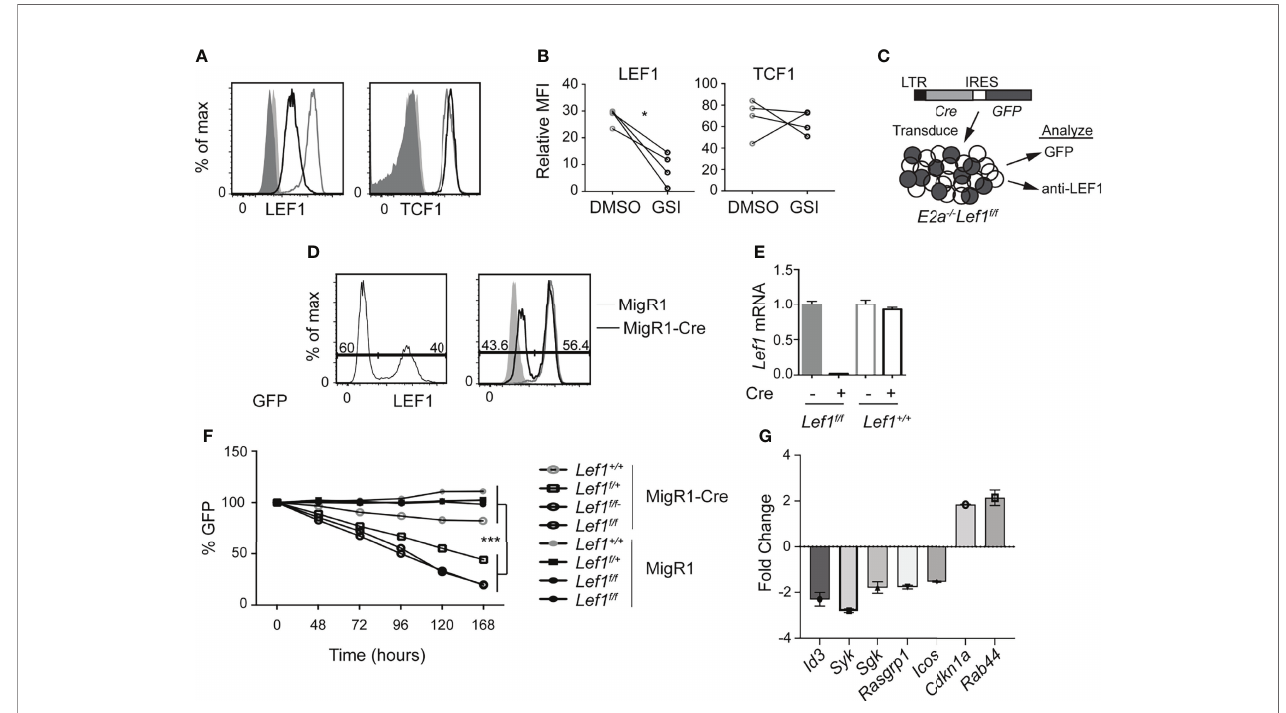
FIGURE 1 | LEF1 is required for the survival of established E2a -/- T cell leukemias. (A) Flow cytometry for LEF1 (left) or TCF1 (right) in an E2a -/- T cell leukemia line treated with DMSO (grey) or the Notch1 inhibitor GSI (black). Shaded histograms are isotype control stainings. n = 4 (B) Summary of the MFI for LEF1 or TCF1 in multiple E2a -/- leukemia lines. *p < 0.05, Students t-test. (C) Schematic representation of experiment to inactivate Lef1 in E2a -/- Lef1 f/f T cell leukemias. (D) Expression of GFP (left) or LEF1 (right) in E2a -/- Lef1 f/f leukemias transduced with MigR1-Cre (black). For LEF1 staining, MigR1 transduced cells (grey) and isotype controls (shaded histograms) are also shown. (E) qRT-PCR analysis for Lef1 mRNA in GFP + cells isolated from E2a -/- leukemias with Lef1 f/f or Lef1 +/+ 96 hours after transduction with MigR1 or MigR1-Cre. Error bars represent standard deviation. (F) The relative percent of GFP expressing cells with time in culture after retroviral transduction of E2a -/- Lef1 +/+ , E2a -/- Lef1 f/+ or E2a -/- Lef1 f/f leukemias with MigR1 or MigR1-Cre retrovirus. Data are representative of n = 4 (A, B) , n = 2 (D, E) and n = 3 (F) experiments. ***p < 0.005. Students t-test on E2a -/- Lef1 F/F and E2a -/- Lef1 F/+ compared to E2a -/- Lef1 +/+ leukemias at t = 168 hours. (G) RNA from a GFP + E2A -/- Lef1 F/F leukemia transduced with MigR1 or MigR1-Cre was analyzed at t = 72 hours by microarray. The graph depicts the FC between MigR1 and MigR1-Cre transduced cells for selected genes and 95% con fi